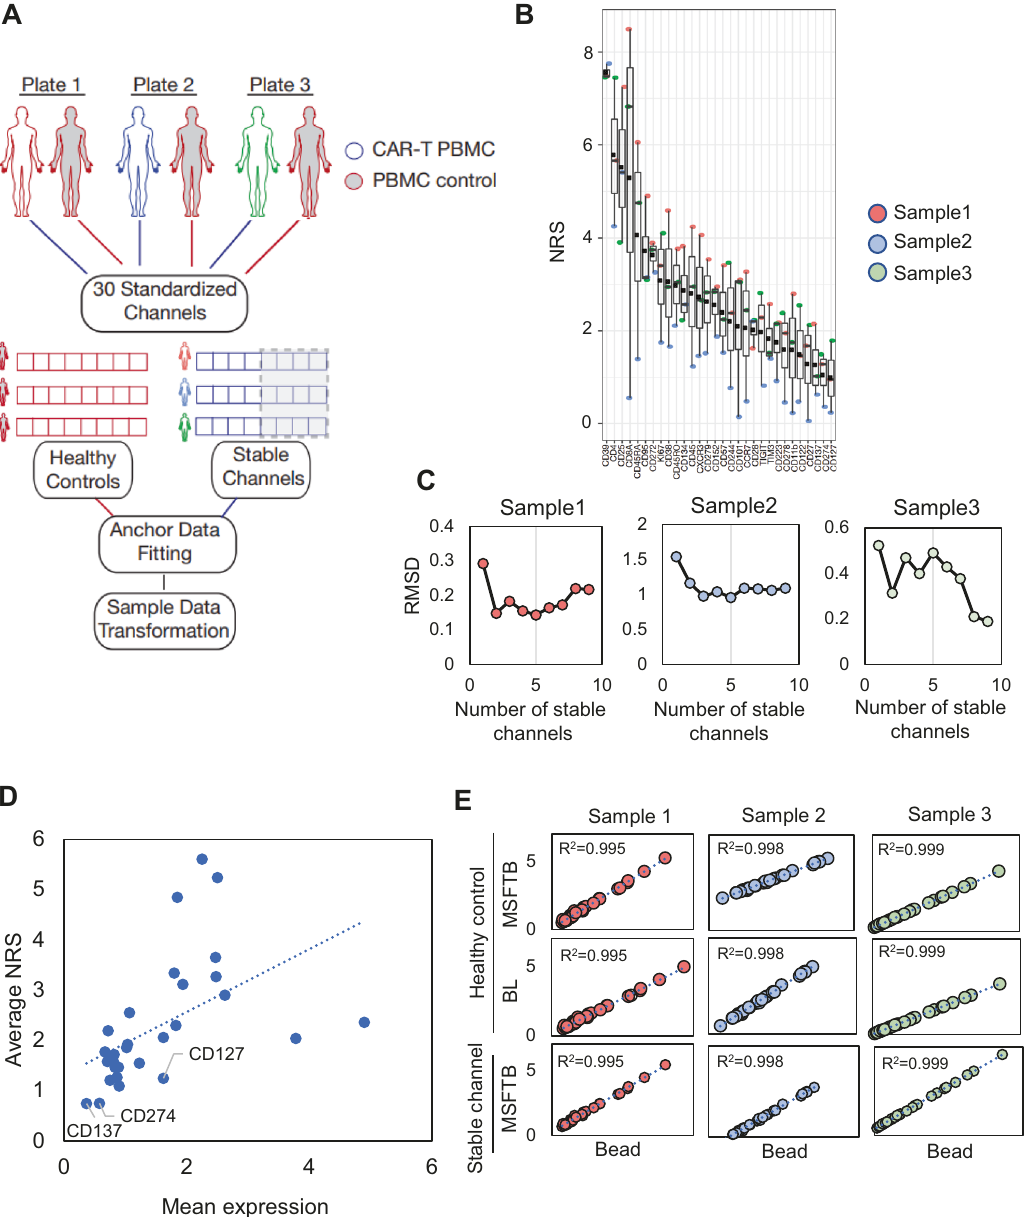
Fig. 5 Evaluation of stable channels as generalized anchors for batch normalization. A The application of CyTOF data integration pipeline to standardize three patient PBMC samples from patients receiving CAR-T cell therapy. Batch normalization was performed using two types of generalized anchors: healthy peripheral blood mononuclear cell (PBMC) samples or stable channels. The generalized anchors were fi tted to the universal reference data distribution followed by data normalization. B Identi fi cation of stable channels using a PCA-based non-redundancy score (NRS) to rank-order marker variability in three CAR-T patient samples ( n = 3). The band indicates the median, the black square indicates the mean, the box indicates the fi rst and third quartiles and the whiskers indicate ± 1.5 × interquartile range. Channels with NRS < 2 were identi fi ed. C To determine the optimal number of stable channels, the RMSD values between batch and bead normalized signals were determined by varying the number of stable channels for each sample. Minimum RMSD values were achieved with the top 3 – 4 stable channels. D Correlation between mean marker expression and channel stability measured by NRS values (R 2 ~0.26). The top three stable channels: CD274, CD137, and CD127 are labeled. E Correlation between batch and bead normalization performance for three CAR-T cell samples using healthy control samples or top three stable channels as generalized anchors. Each dot represents the mean expression of 30 consensus markers normalized by bead ( x -axis) or by batch normalization ( y -axis). The correlation values were computed across 30 consensus markers for each sample. Batch normalization using stable channels normalized by either MSFTB or BL normalizations achieved comparable performance to that using external anchors with R 2 values> 0.9. Source data are provided as a Source Data fi Conversely, Wei et al. found CD8 + PD1 + T cells were expanded in PBMC samples of melanoma patients treated with Nivolumab, Pembrolizumab, or Ipilimumab (a CTLA4 inhibitor) monotherapy, but the effects of these immunotherapies on CD4 + PD1 + T cells